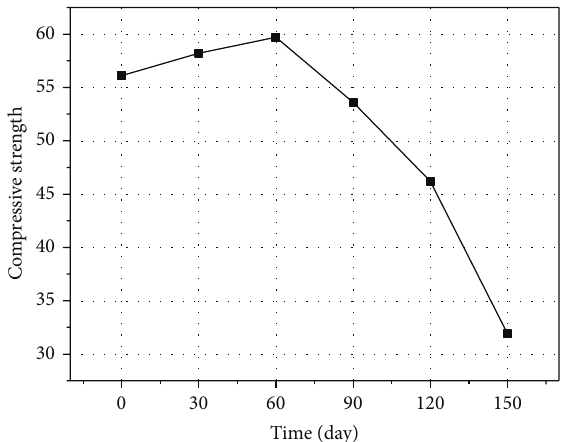
Figure 3: Variation in the average value of the compressive strength of corroded